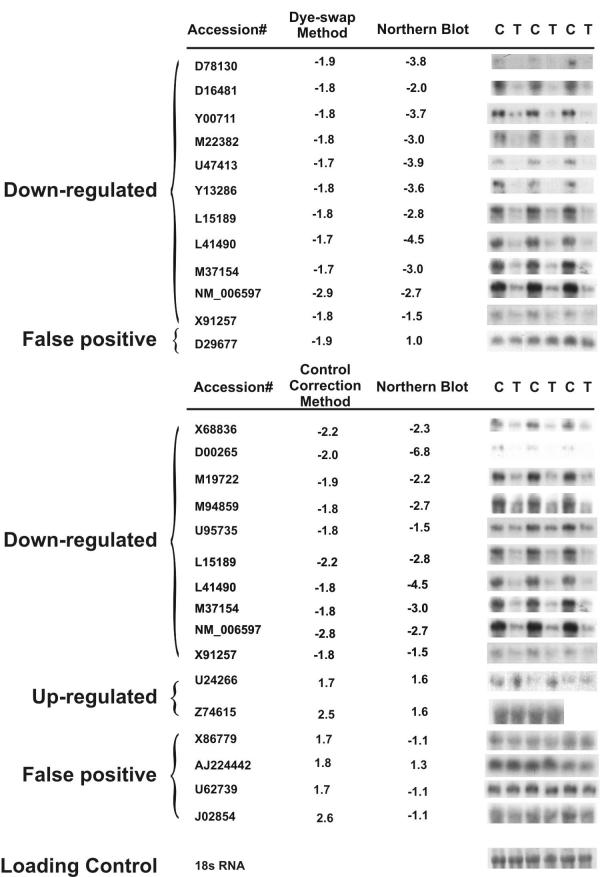
Northern blots confirm a majority of gene expression changes for both methods. The far right-hand column shows northern blot results performed in triplicate for genes identified by each microarray design method. For each gene, the fold-change from the microarray together with the average fold-change quantified from the northern blots is shown. To correct for loading differences, in the northern blots each measurement was normalized to the corresponding amount of 18S rRNA measured on each gel. A representative example of the 18S rRNA is shown on the bottom of the figure. Two of the Z74615 northern blot bands were discarded due to contamination. Down-regulated, up-regulated, and false positive genes that were not confirmed by northern blots are indicated.